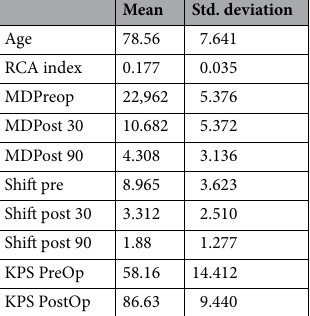
Table 2. Descriptive statistics of CSDH